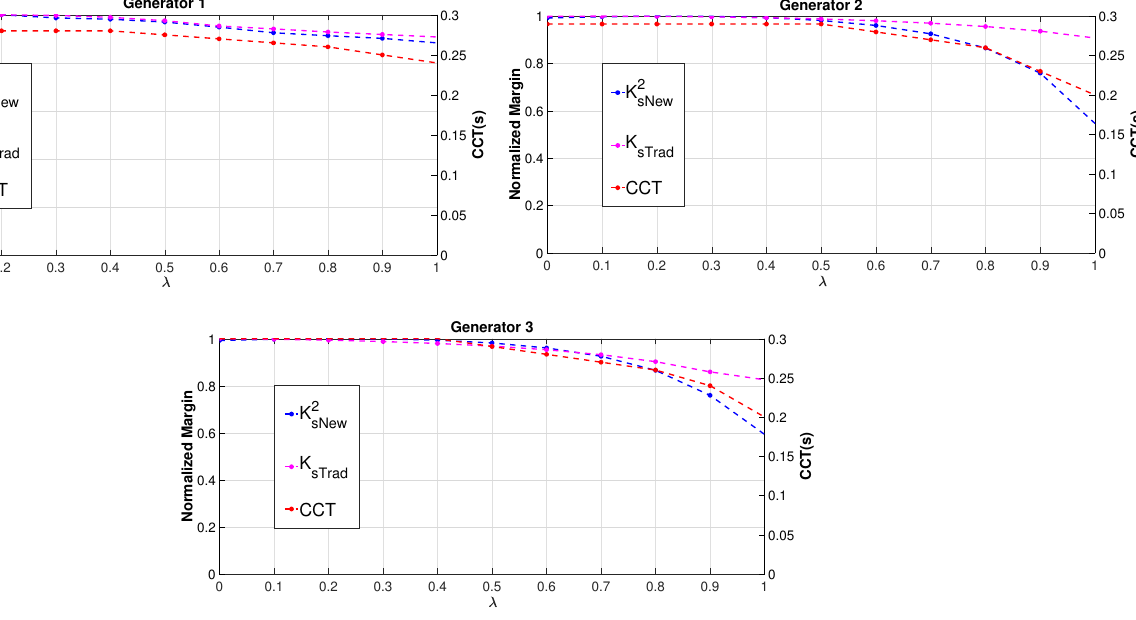
Figure 1. Transient stability margin of generators in WSCC 9-bus test system for mode 1.